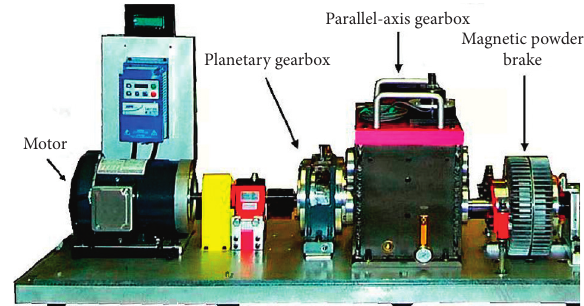
Figure 3: The experiment